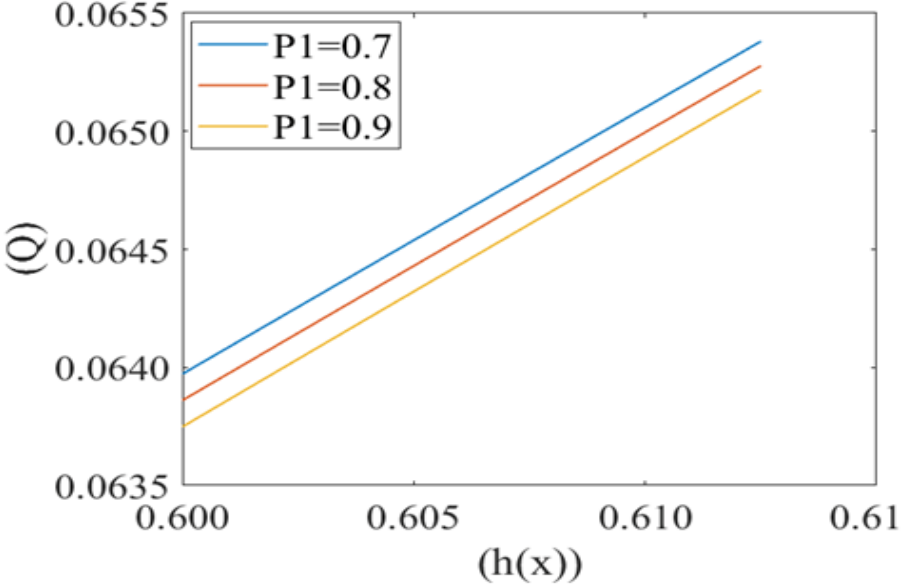
Figure 7. Variation of flux per unit length in back ward direction (leak back ( Q )) with the height of plasma film h(x) at different values of mean pressure gradient in the capillary ( P1